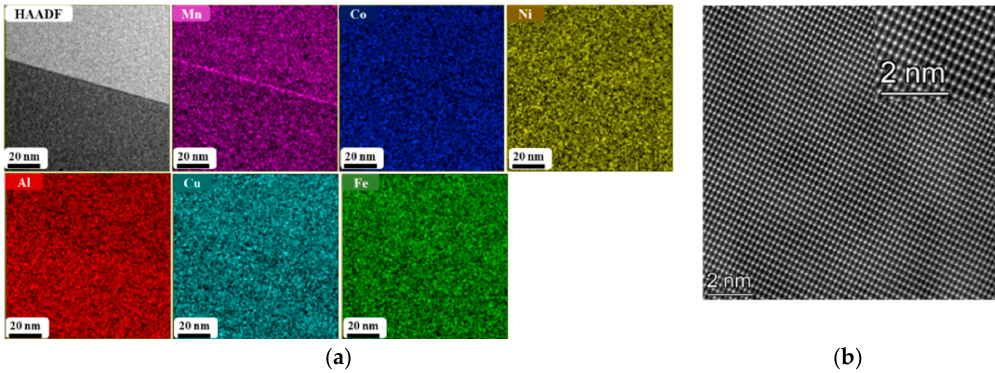
Figure 11. Aberration-corrected HAADF-STEM analysis of Al(CoCuFeMnNi) B2 aluminide shows ( a ) HAADF-STEM image and corresponding STEM-EDS elemental maps of constituent elements; ( b ) the atomically resolved HAADF-STEM image of the B2 ordered lattice.